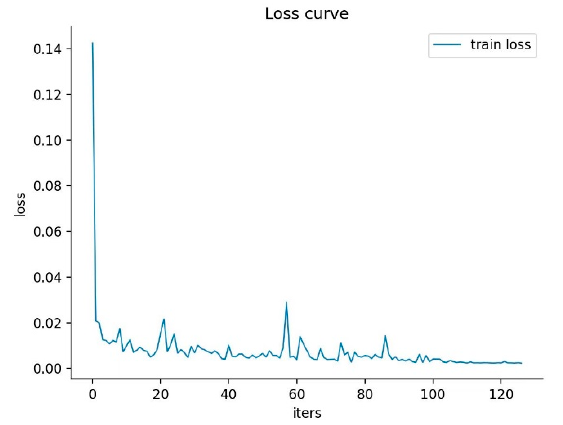
Figure 11. Epoch-loss plot of the model training process.